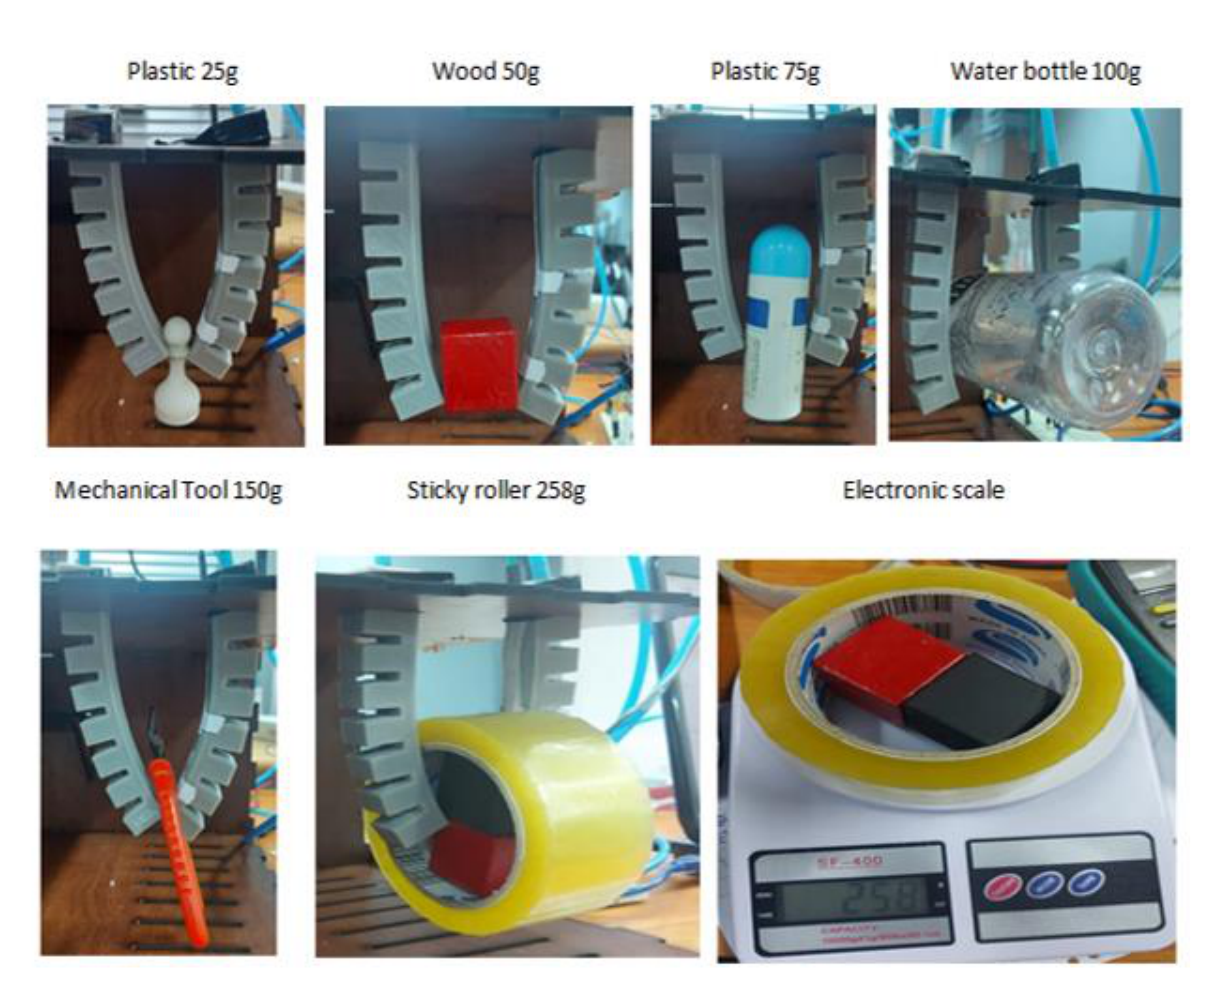
Figure 15. Different loads and different material.